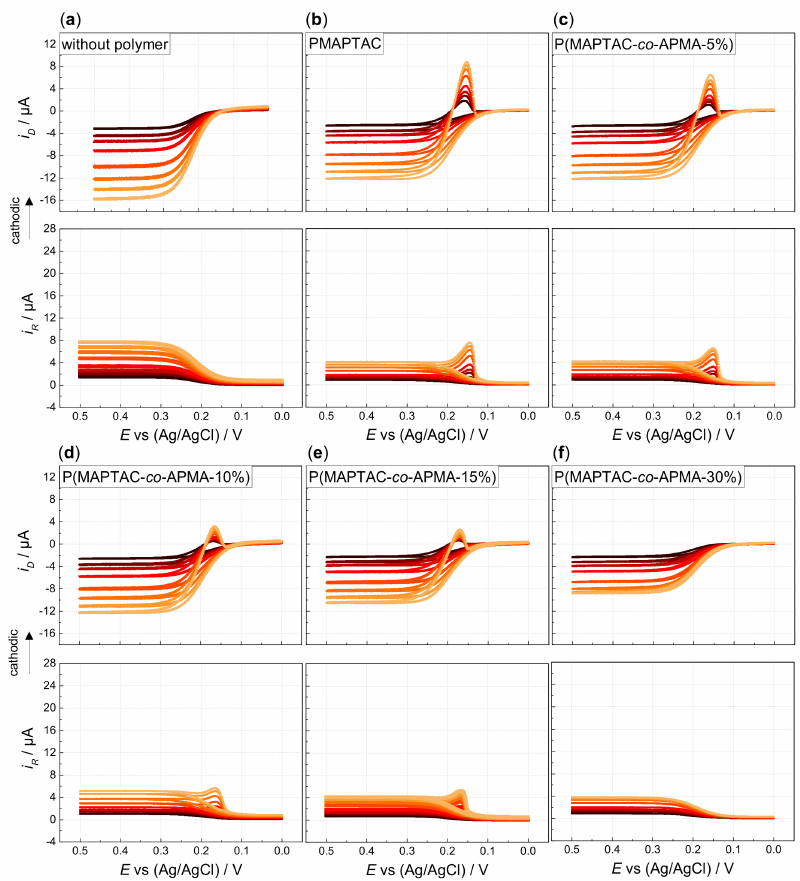
Figure 1. Hydrodynamic voltammograms of 0.13 mM HCF(II) in 0.1 M KCl in ( a ) absence and presence of 0.52 mM (with respect to quaternized polymer units, icr = 1); ( b ) PMAPTAC; ( c ) P(MAPTAC- co -APMA-5%); ( d ) P(MAPTAC- co -APMA-10%); ( e ) P(MAPTAC- co -APMA-15%) and ( f ) P(MAPTAC- co -APMA-30%) (ring potential at 0 V vs. Ag/AgCl, disk potential scanned from 0 to 0.5 V (forward scan) and back to 0 V (backward scan) vs. Ag/AgCl with ν = 5 mV/s, rotation rates increase as indicated from black to orange: 200, 400, 600, 1000, 2000, 4000, 5000